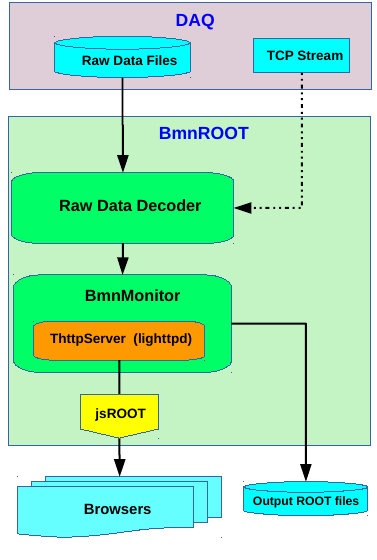
Figure 1. Data processing